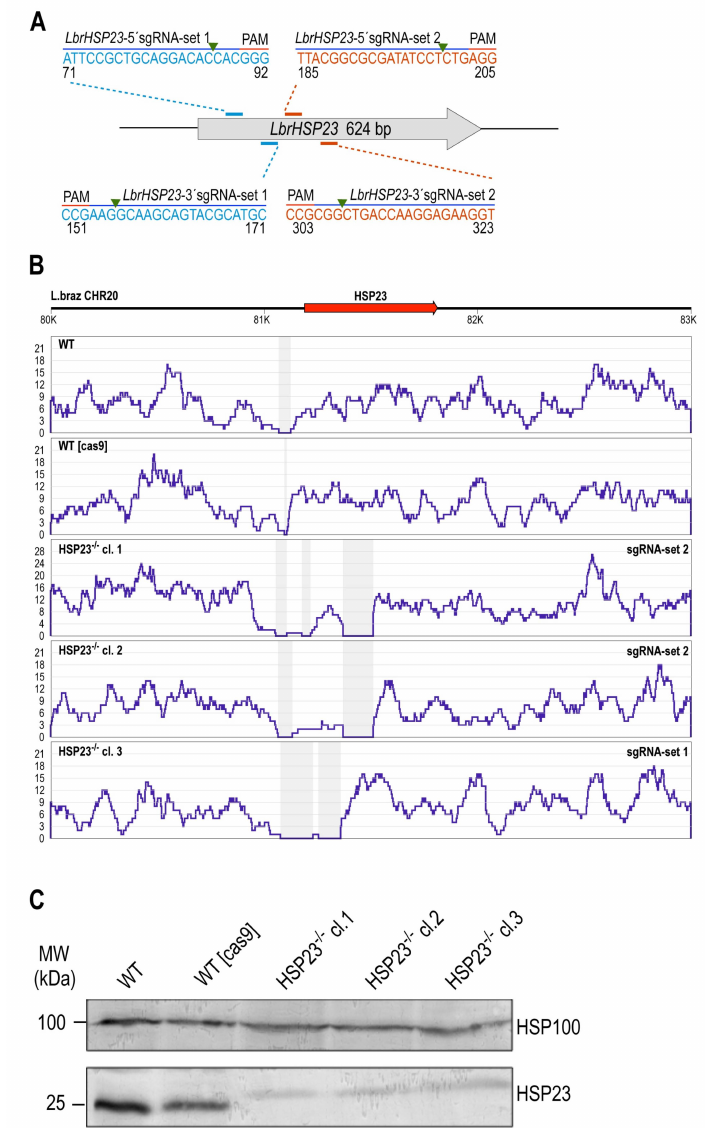
Figure 2. CRISPR–Cas9-mediated disruption of the endogenous HSP23 gene in L. braziliensis . ( A ) Schematic representation of the LbrHSP23 locus depicting the locations of 20-nt guide sequences that worked e ffi ciently to disrupt the LbrHSP23 ORF. Two sets of sgRNAs were tested (set 1 and set 2): set 1 = LbrHSP23 -70-5’sgRNA and LbrHSP23 -171-3’sgRNA; set 2 = LbrHSP23 -183-5’sgRNA and LbrHSP23 -323-3’sgRNA. Both pairs are designed to disrupt the conserved functional alpha-crystallin domain of HSP23 (amino acid positions 6–104). The guide sequence pairs with the DNA target (blue bar) directly upstream of a requisite 5 (cid:48) –NGG–3 (cid:48) adjacent motif (PAM). The green arrowhead indicates the predicted Cas9 cleavage sites. Only the coding strand sequence is shown. ( B ) NGS analysis of the HSP23 locus after CRISPR–Cas9-mediated gene replacement. Genomic DNA of L. braziliensis PER005cl2 wild-type parasites (WT), the parental cell line WT [Cas9] and HSP23 – / – mutant clones was isolated and subjected to NGS analysis. Resulting NGS reads were aligned to the HSP23 gene locus (LbrM.20.0220) in the L. braziliensis M2904 reference genome using the Bowtie 2 algorithm. The read coverages (Y-axis) for the gene locus are shown in blue. The arrow represents the position and direction of the coding sequence. The X-axis numbering refers to the nucleotide position (bp) on chromosome 20. Grey-shaded areas denote lack of aligned reads. ( C ) Verification of HSP23 gene replacement by Western blot analysis. 1 × 10 7 cells of WT, WT [Cas9], and of 3 HSP23 – / – clones were lysed and the cell lysates were analysed by SDS-PAGE and Western blot using anti-HSP23 (1 / 500, lower panel). Anti-HSP100 (1 / 1000, upper panel) was used as loading control. MW = Molecular weight in